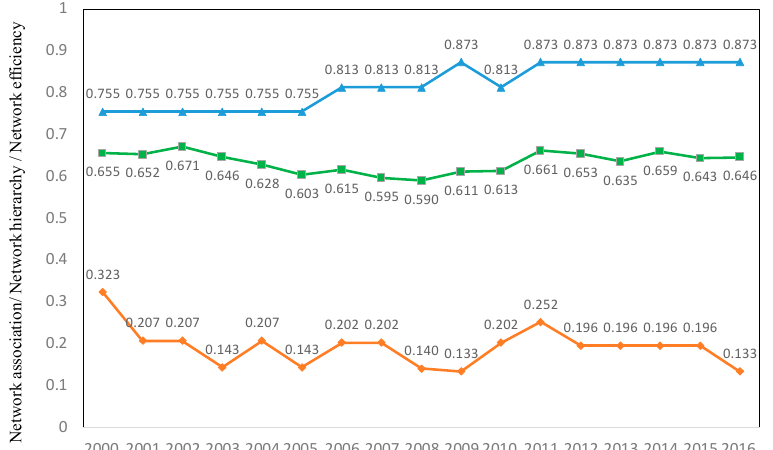
Figure 3. Network relevance.